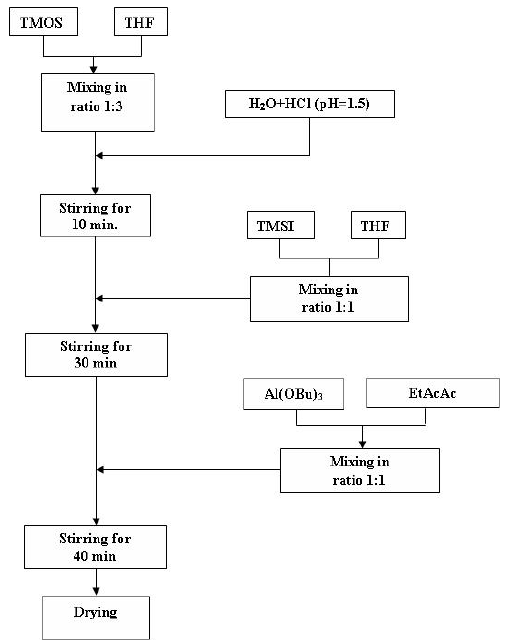
Figure 1. Schematic diagram for the synthesis of the hybrid material containing